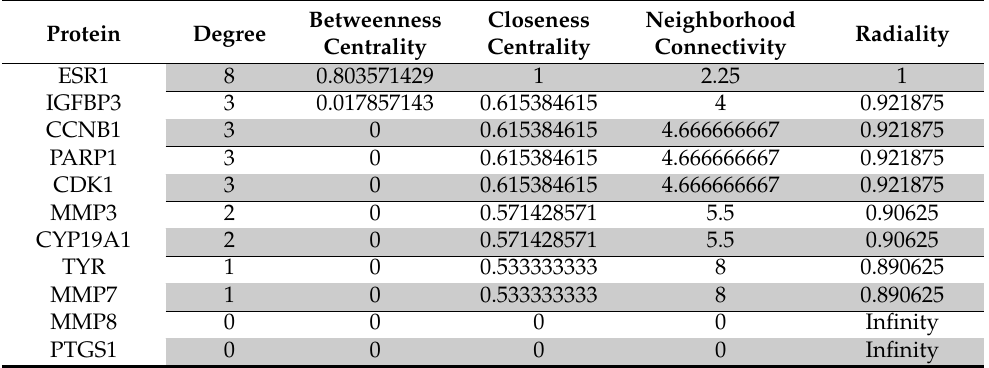
Betweenness Closeness Neighborhood Radiality Centrality Centrality Connectivity